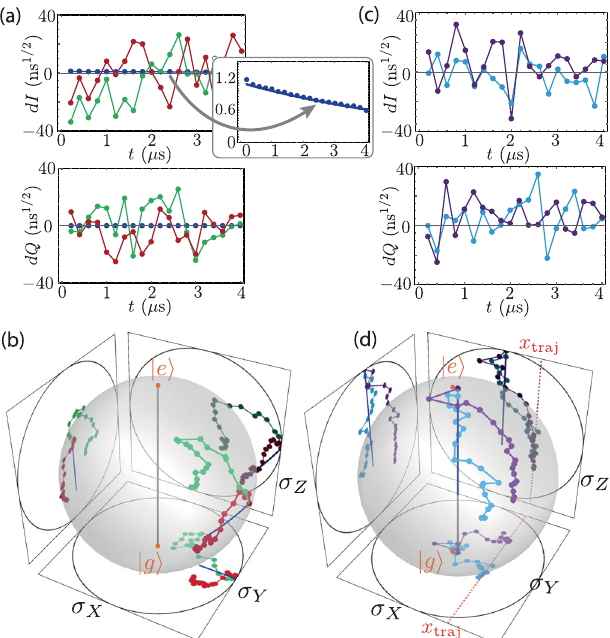
FIG. 2. Quantum trajectories. (a) Each panel displays two different measurement records of one quadrature of the fluores- cence field for a qubit initially in j þ x i . Actual measurements are shown as red and green dots linked by straight lines for clarity. FIG. 1. Scheme of the experiment. (a) The fluorescence field of The blue dots correspond to the average record on all experi- a superconducting qubit in an off-resonant cavity is recorded ments, and the blue line corresponds to an exponential fit of these using a heterodyne detection setup from time 0 to T . Following dots in e − γ 1 t= 2 − γ ϕ t . A zoom-in is shown as an inset. Measurements amplification by a Josephson parametric converter (JPC), the 100 MHz and numerically signal is down-converted to f of dI and dQ are normalized by an overall prefactor so that their h ¼ variance is dt [28]. (b) Quantum trajectories followed by the qubit demodulated and integrated on time steps dt ¼ 200 ns into its under relaxation represented in the Bloch sphere for the meas- two quadratures dI and dQ . The rectangular symbols represent urement records shown in (a). The Bloch vector ð x; y; z Þ the correction of finite detection bandwidth in the setup [28]. The corresponds to the state ρ ¼ ð 1 þ x σ quantum trajectory f ρ is then computed using Eq. (2). A single t g f local oscillator at f is used for qubit manipulation and black circles set the scale of the Bloch sphere extrema. The q þ h trajectories are obtained by solving numerically Eq. (2) and are down-conversion of the fluorescence signal. The transmission at 7 . 8 GHz is used to independently read-out shown as dots linked by straight lines both in the sphere and in the cavity frequency f c ¼ three projections along x , y , and z . Colors identify which record the qubit at time T [28]. (b) Pulse sequence. At time 0, the qubit is of (a) is used. A blue line shows the average evolution without prepared in j þ x i ( j þ e i ) with a 52 ns (104 ns) rotation pulse monitoring ( η ¼ 0 ). (c), (d) Same representations for two realiza- around σ . The fluorescence record is acquired for a duration T y tions starting from j e i . They are arbitrarily selected to end up ranging from 0 to 10 μ s. The state is then projectively read-out in a state with similar Bloch coordinate x along one of the three Pauli operators using a pulse at frequency f as indicated by a dashed red preceded by a rotation pulse around σ , σ , or no pulse. c y x